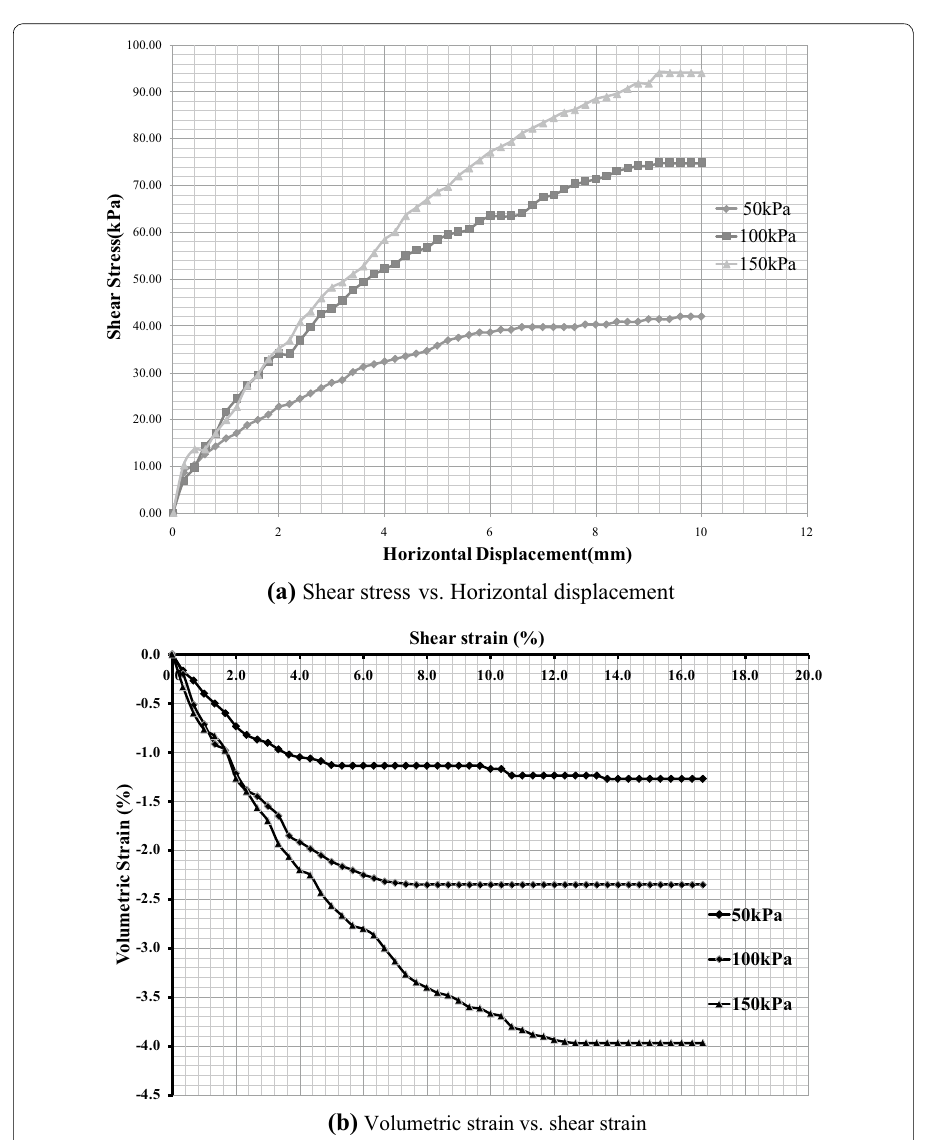
Fig. 7 Direct shear test